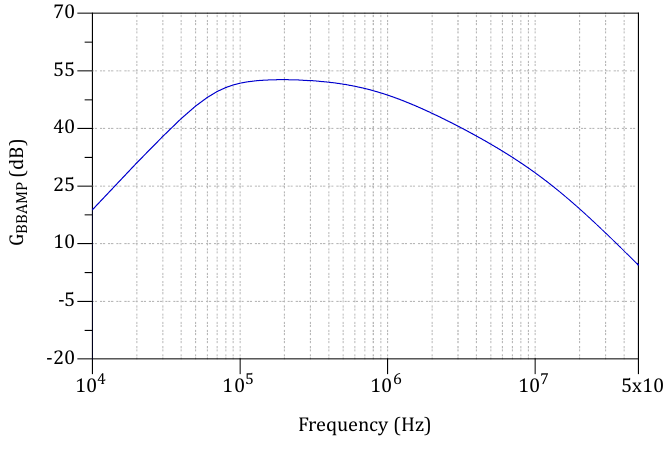
Figure 9. BBAMPS voltage gain vs. frequency.